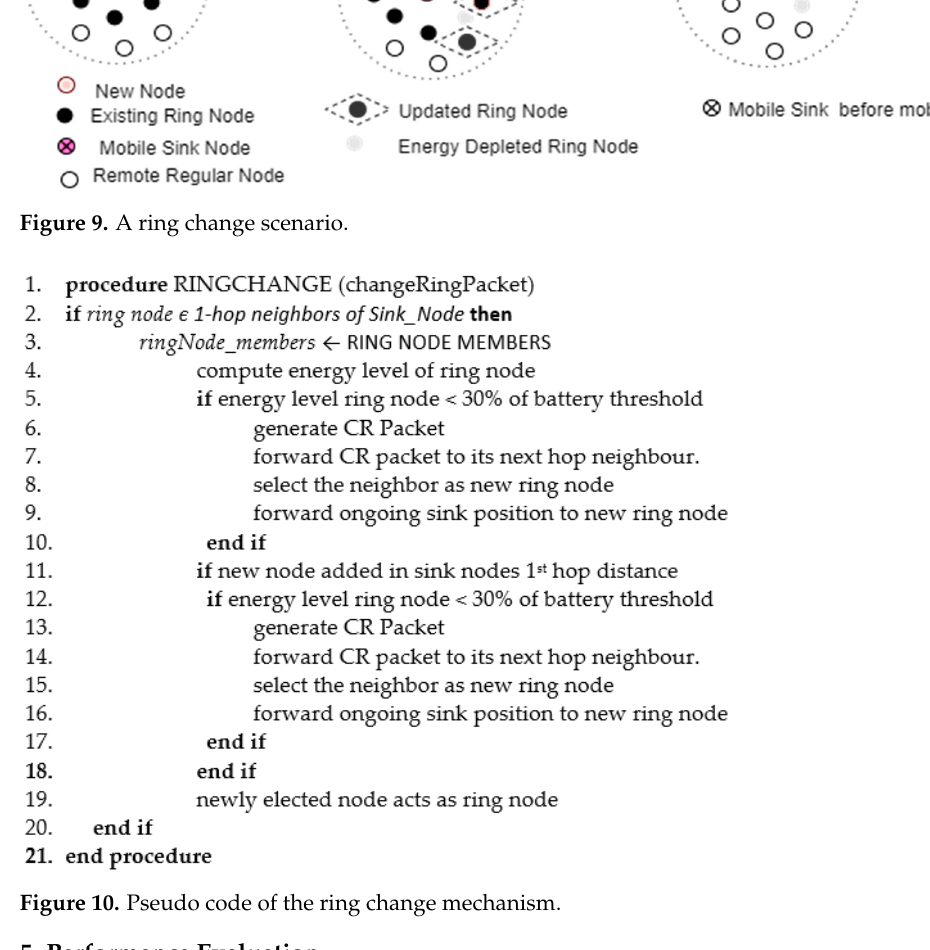
11 of 19 Figure 7 . Pseudo code for the procedure of the SPIREQ and SPIRESP packets.